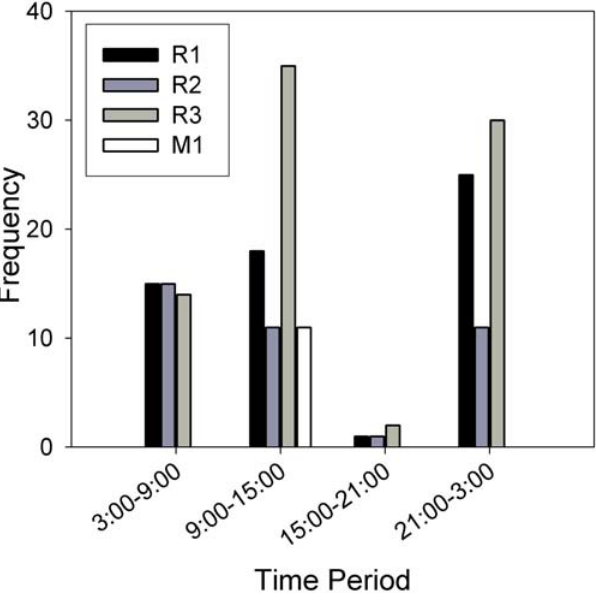
Figure 6. Total adults recovered of 3 genotypes of S.rodhaini (R1-R3) and 1 genotype of S.mansoni (M1) that emerged from the same snail during 4 time intervals.